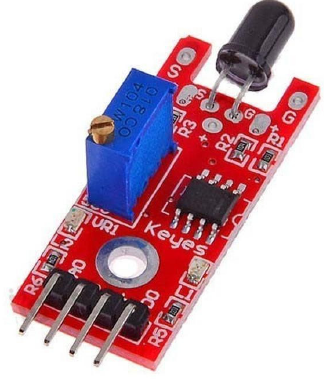
Figure 5. Flame Sensor used in SMDD.